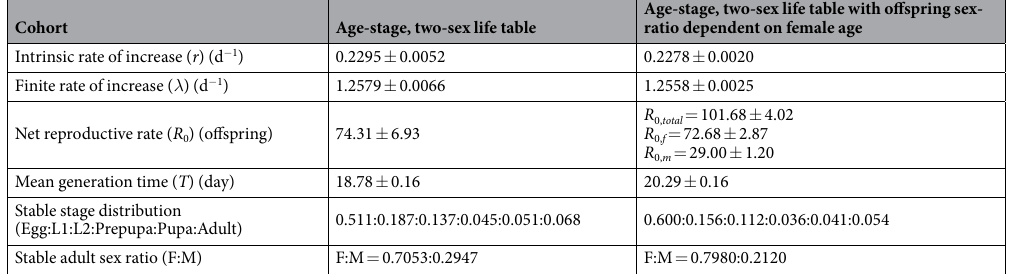
Table 3. Population parameters of bisexual cohort of Frankliniella occidentalis (L1, the first instar; L2, the second